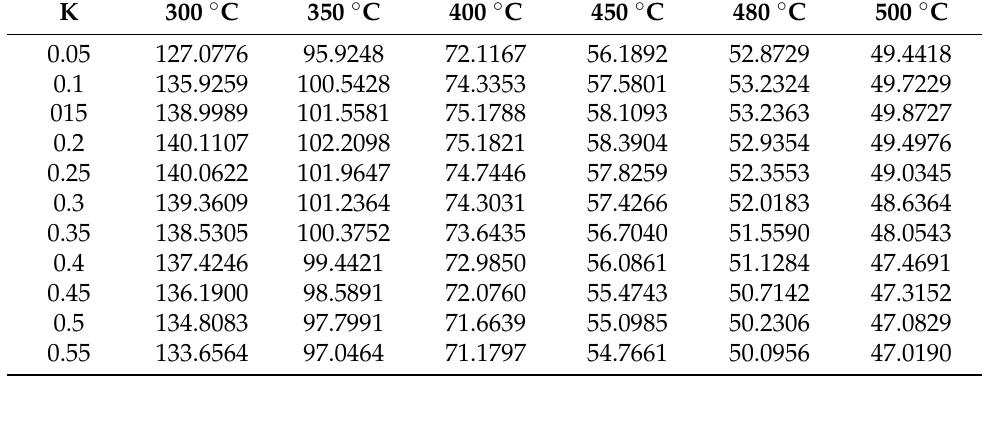
Table 7. The value of material parameter K under different deformation conditions.